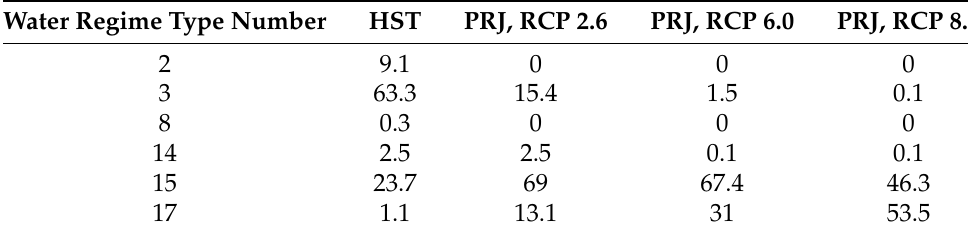
Table 3. The percentage of the total study area under each water regime type derived for the historical and projected